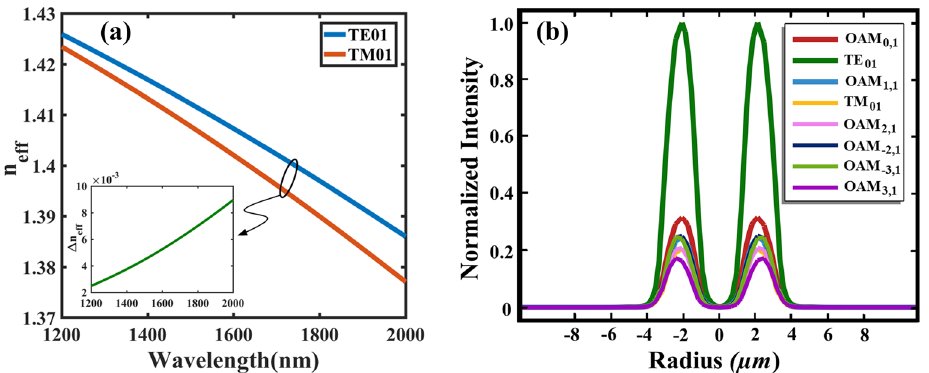
TM 01 and OAM l,m modes while the same input intensity is assumed.